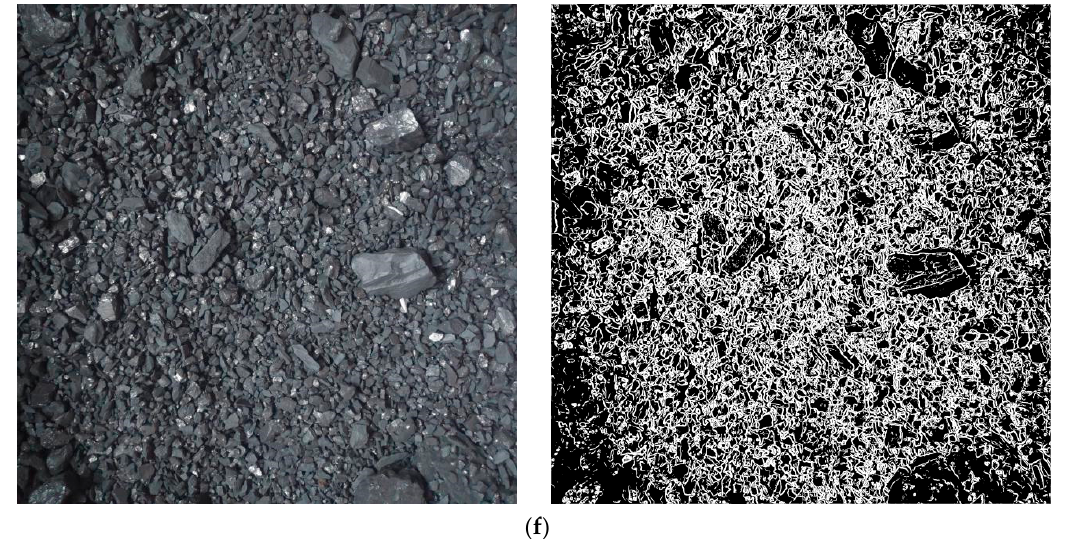
Figure 9. Different coal-edge image under different coal-screening efficiencies. ( a ) 100% screening efficiency; ( b ) 80% screening efficiency; ( c ) 60% screening efficiency; ( d ) 40% screening efficiency; ( e ) 20% screening efficiency; ( f ) coal image before screening.